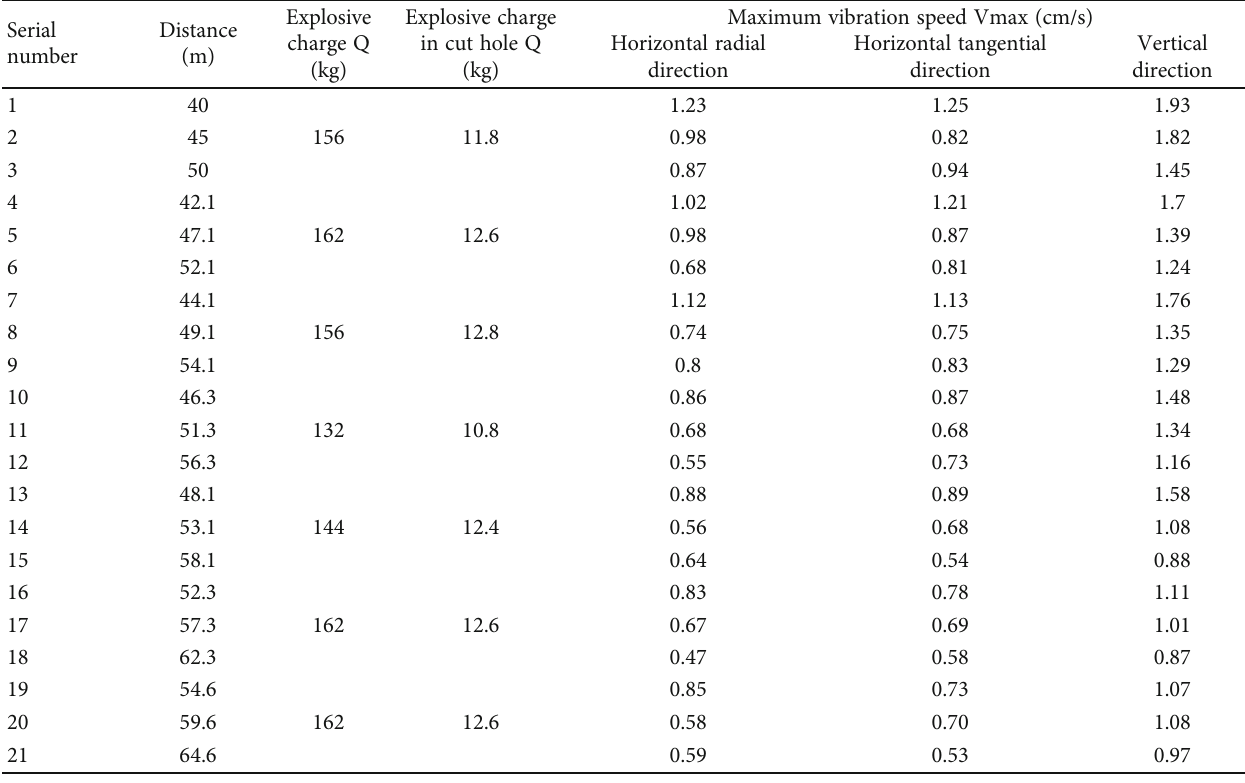
Table 1: Monitoring data of the particle vibration velocity of the cut hole.